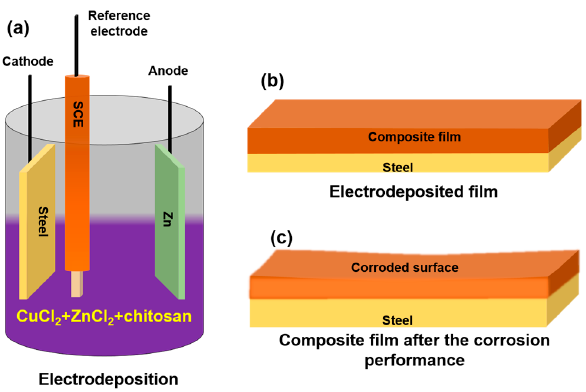
Figure 1. Schematic diagrams of the chitosan-Zn 1 − x Cu x O composite thin film. Electrosynthesis ( a ) and structure of the films before ( b ) and after ( c ) corrosion performance testing.